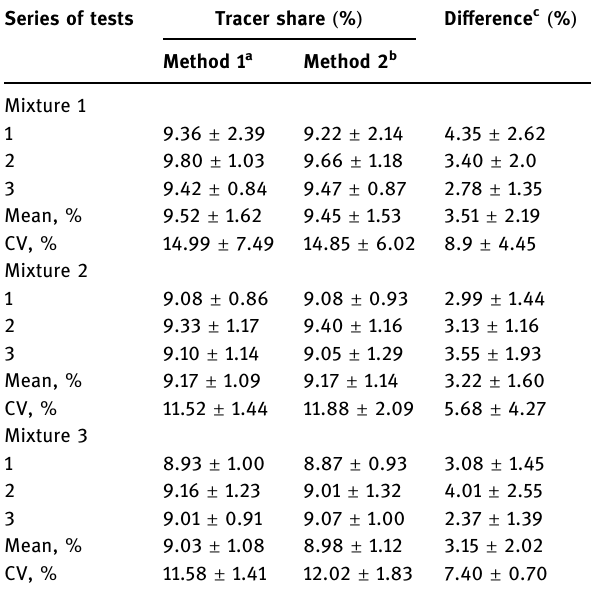
Table 2: Results of mixing of compound feeds for cattle using a tracer with an average particle size d 1 = 2.00